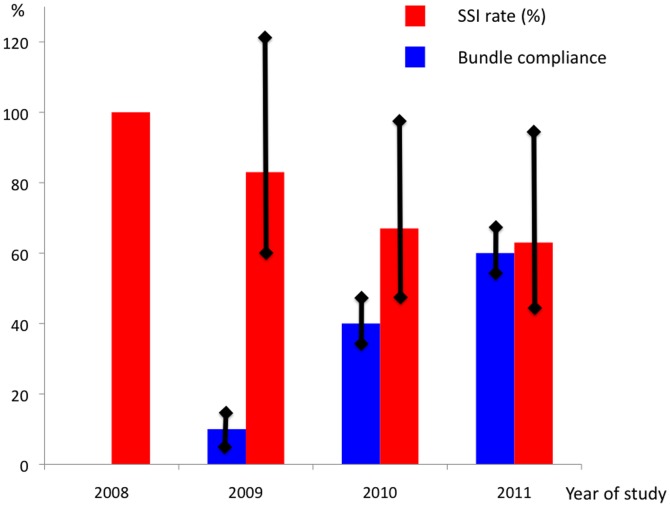
Annual changes in the surgical site infection (SSI) rate and bundle compliance and the 95% confidence interval.Footnote: 2008 was taken as the reference year for SSI and the relative changes after adjustment for confounding variables are provided.